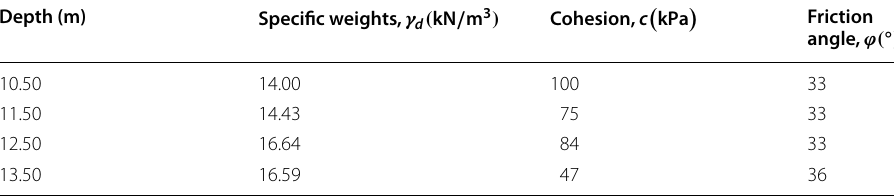
Table 1 Mechanical characteristics of pasty chalk of Nogent-sur-Seine (France) Depth (m) Specific weights, γ d ( kN / m 3